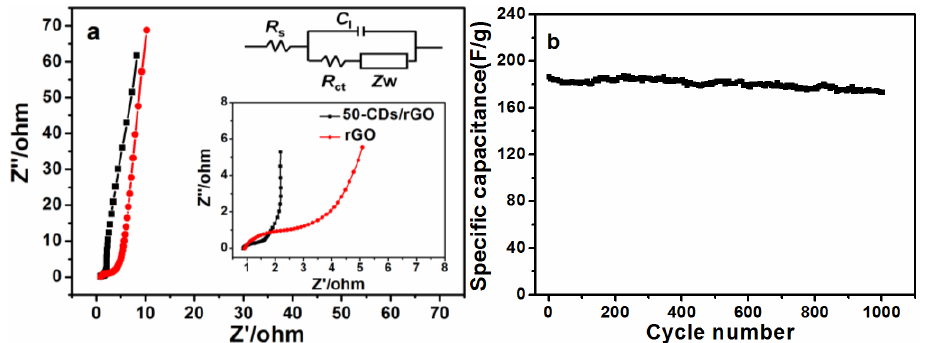
Figure 8. ( a ) Nyquist impedance plot of the rGO and 50-CDs/rGO electrodes. Inset is an expanded view in the region of high frequencies and an equivalent circuit model; ( b ) the specific capacitance of the 50-CDs/rGO supercapacitor for charging/discharging as a function of cycle number measured at a current density of 1 A/g.